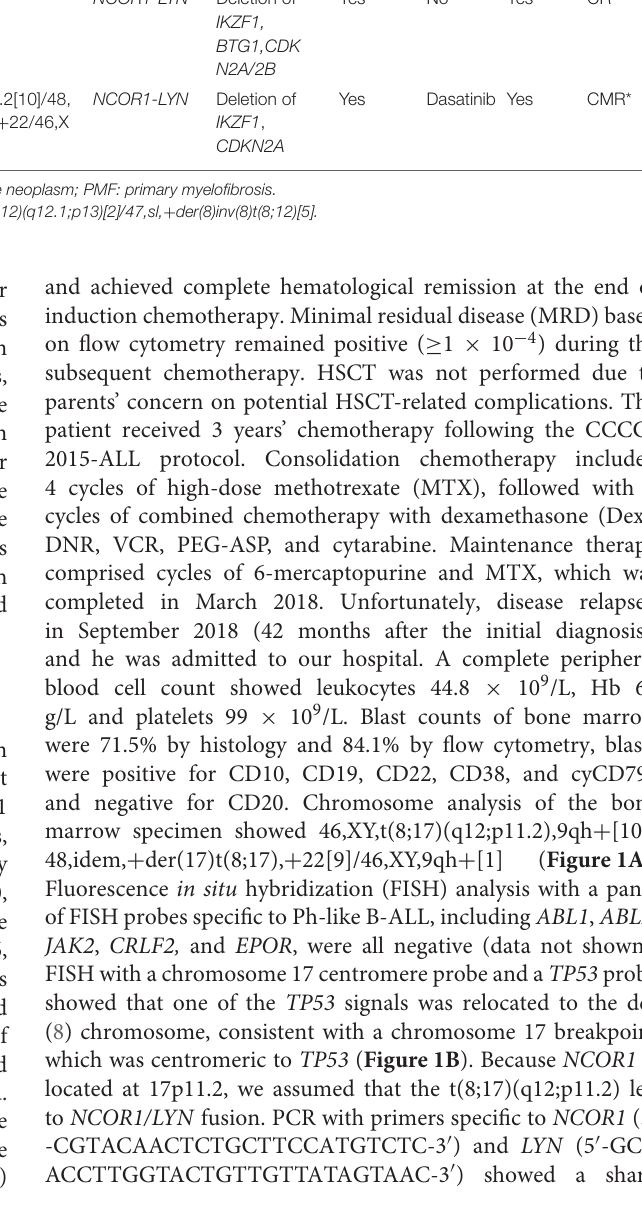
Additional Relapse TKI Allo- Clinical gene genetic HSCT changes